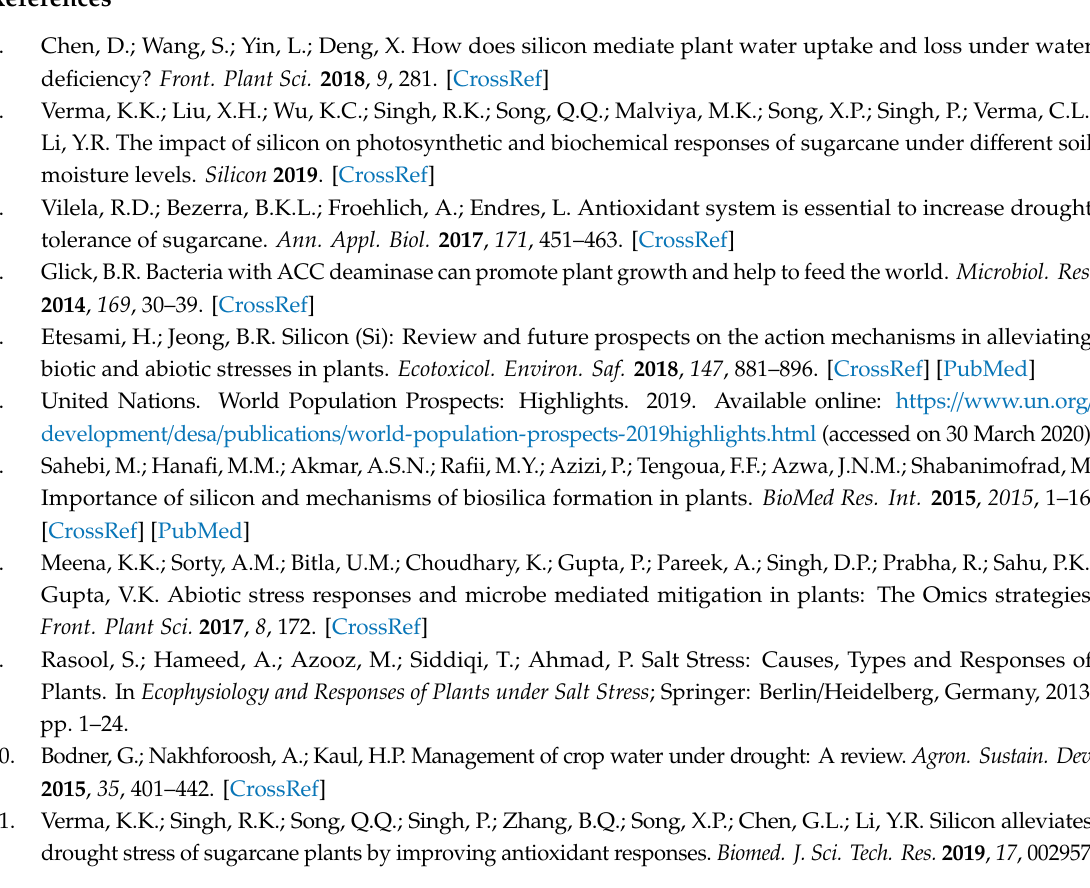
Figure S1: Outline indicates the days of plants period of the whole experiment, Table S1: Soil properties in the stusy, Table S2: Model parameters of morpho-physiological and antioxidant enzymes in responsive to di ff erent soil moisture levels with